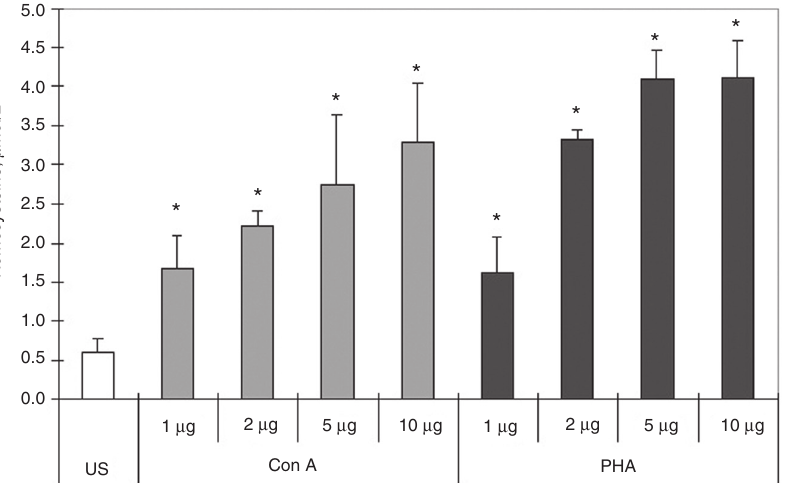
Figure 3 Homocysteine concentrations determined in the supernatants of unstimulated (US) and mitogen-stimulated T lymphocytes (Con A , concanavalin A; PHA , phytohemagglutinin). Significant differences are indicated by an asterisk (*p < 0.01).